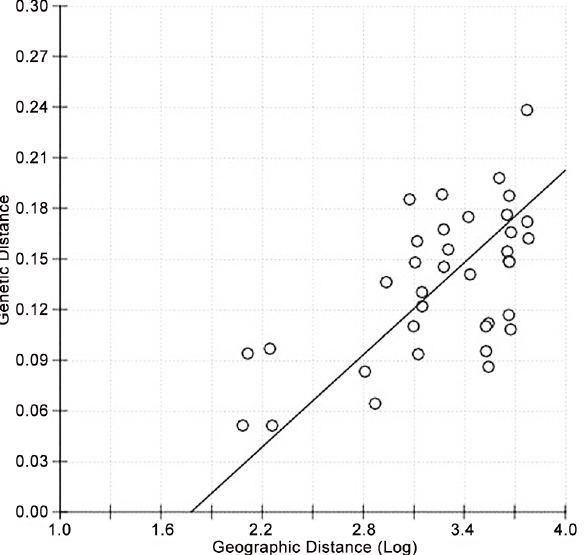
Fig 2. Correlation between the geographic and genetic distance matrices. The regression line corresponds to the standard major axis regression between pairwise genetic distances and logarithmic geographic distances with equation: Fst = - 0.1620 + 0.09113 (cid:3) log (geographic distance). The relationship was significant (Mantel test: Z = 16.3746; r = 0.6164; P < 0.001).